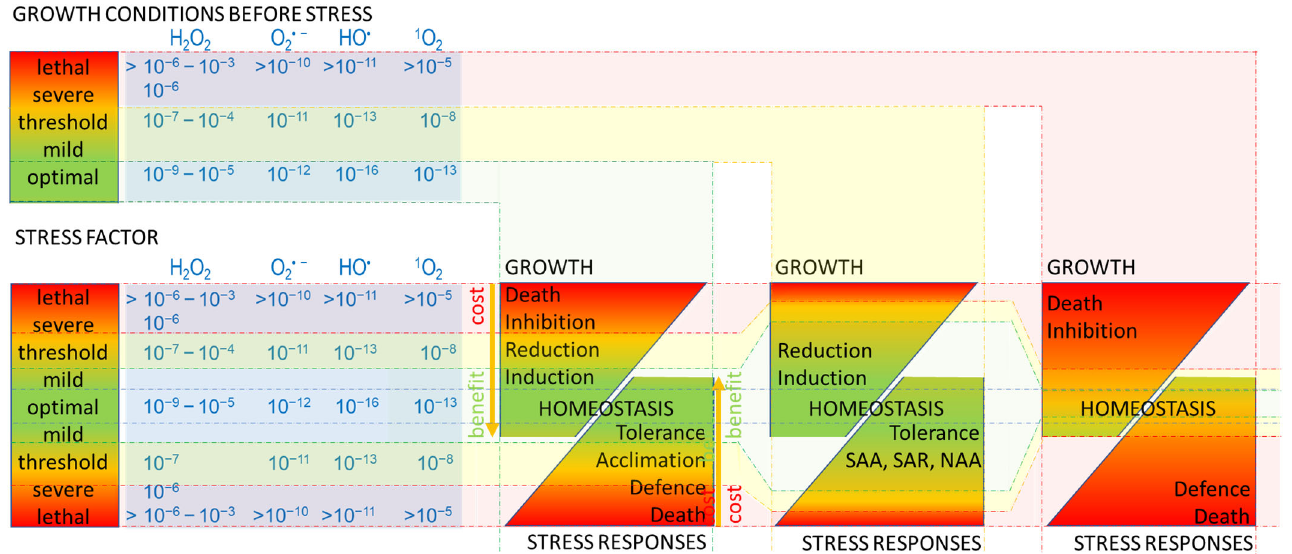
Figure 1. Response to the stress factor is determined by growth conditions prior to stress, the intensity of the stress factor, and ROS generated under stress. The higher intensity of the ‘stress’ factor ranging from optimal (green) to lethal (red), the higher is ROS level in cells and organisms (blue panel). ROS type (e.g., H 2 O 2 , O 2 •− , HO • , 1 O 2 ) and concentration (e.g., lower for animals and humans 10 − 9 –10 − 6 M H 2 O 2 ; than for plants 10 − 6 –10 − 3 M H 2 O 2 ) can influence the